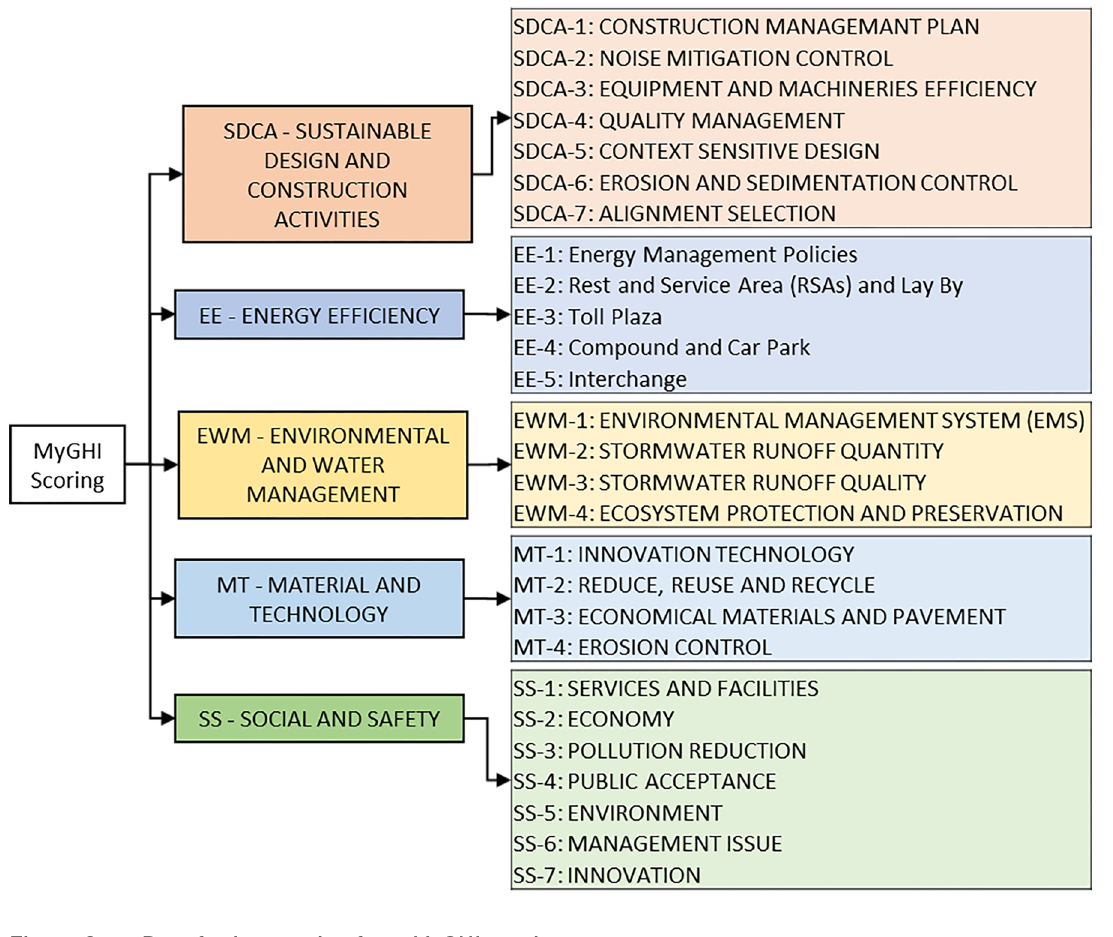
Figure 2. Data for integration from MyGHI